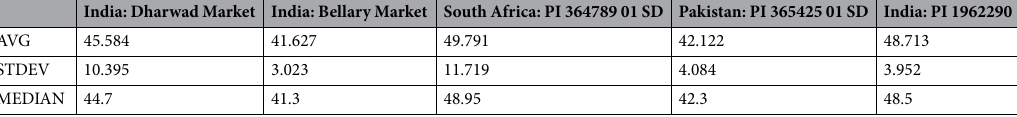
Table 2. Testa thickness measurements on modern horsegram specimens, sectioned and measured under SEM, giving the range of testa thicknesses around the perimeter of a single seed. The data is presented as mean, standard deviation, and median. Accessions with PI numbers were obtained as germplasm samples from USDA. (For additional individual measurements see Table S1 in data supplement).